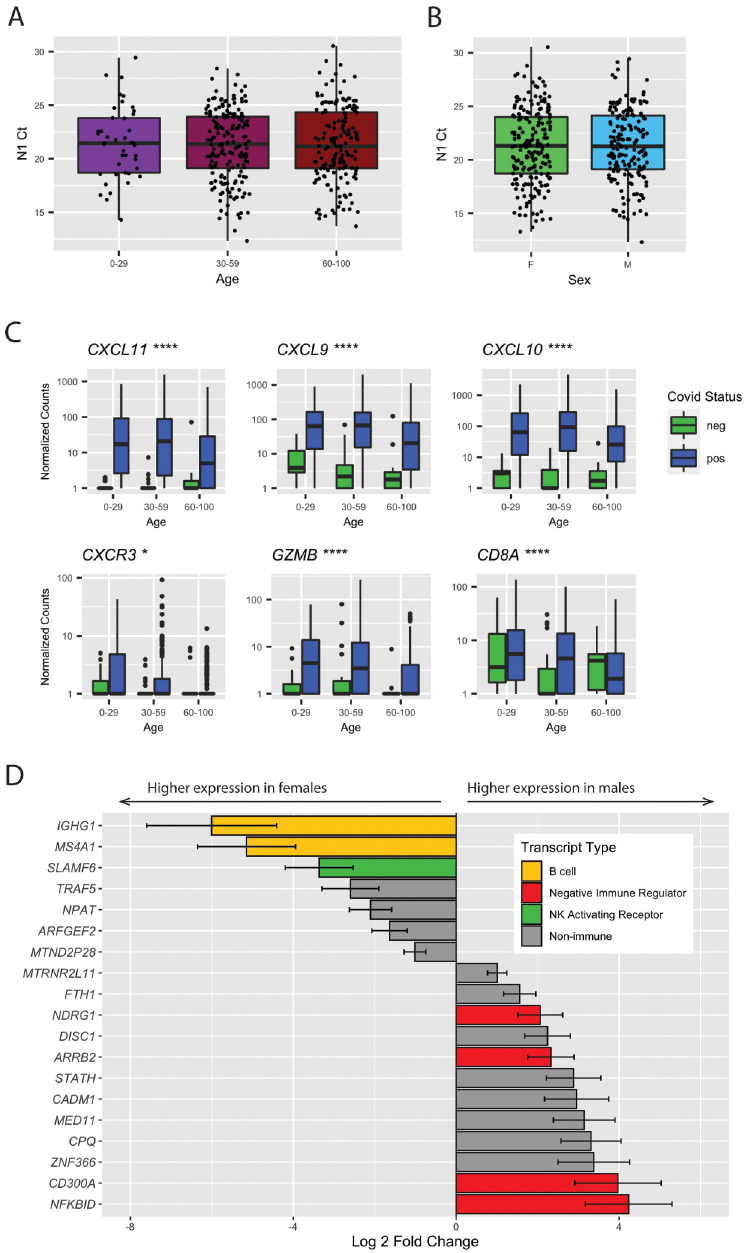
Fig 5. Age and sex cause differences in gene expression upon SARS-CoV-2 infection. (A) N1 Ct values by age group. No significant differences between were observed by Kruskal-Wallis ANOVA. (B) N1 Ct values by sex. No significant difference between groups was observed by t test. (C) Gene expression differences by age and viral load. Significance by Mann Whitney U test between SARS-CoV-2-positive samples aged > 60 and < 60 is shown, � p < 0.05, �� p < 0.01, ��� p < 0.001, ���� p < 0.0001. (D) Sex-modulated DE genes ( p adj < 0.1) upon SARS-CoV-2 infection. Genes elevated in females are shown as negative log2 fold changes, and those elevated in males as positive log2 fold changes. Raw data available in the GEO Repository, accession GSE152075. Ct, cycle threshold; DE, differentially expressed; GEO, Gene Expression Omnibus; N1, SARS-CoV-2 nucleocapsid gene region 1; NK, natural killer; SARS-CoV-2, severe acute respiratory syndrome coronavirus 2.